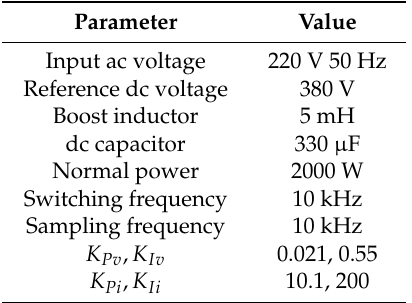
Table 2. Specification of Simulation and Experiment.